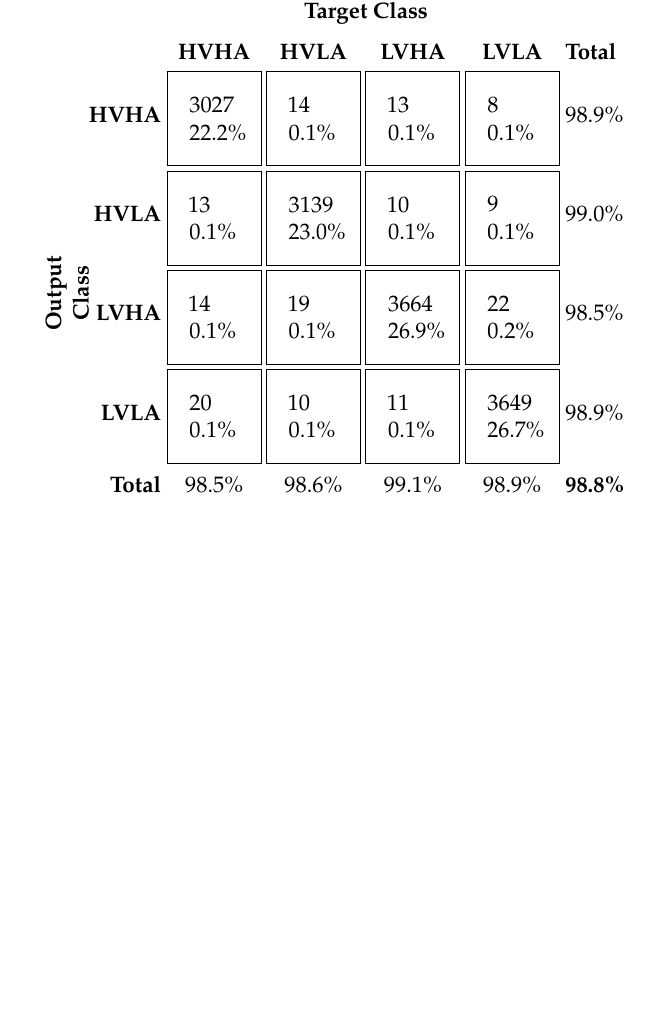
Table 10. Confusion matrix of ECG right modality for AMIGOS